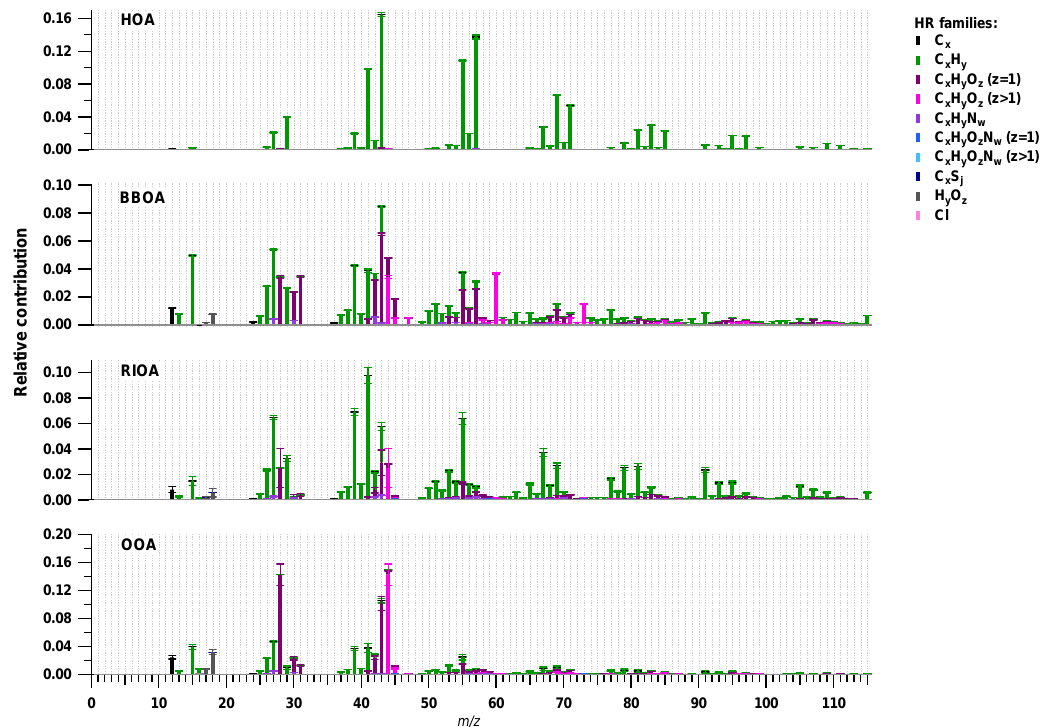
Figure 2. Mass spectra of the four OA sources identified with PMF. From top to bottom: hydrocarbon-like OA (HOA), biomass burning OA (BBOA), residential influenced OA (RIOA), and oxygenated OA (OOA). Error bars indicate the standard deviation among 100 bootstrap runs. Table 2. Correlation coefficients ( R 2 ) between the OA profiles from the four-factor solution and literature profiles. The different nomen- clatures used in the literature for the OOA factors have been homogenized to a semi-volatile OOA (SVOOA) and a low-volatility OOA (LVOOA). R 2 Aiken et al. (2009) Mohr et al. (2012) Setyan et al. (2012) Crippa et al. (2013b) HOA-HOA 0.82